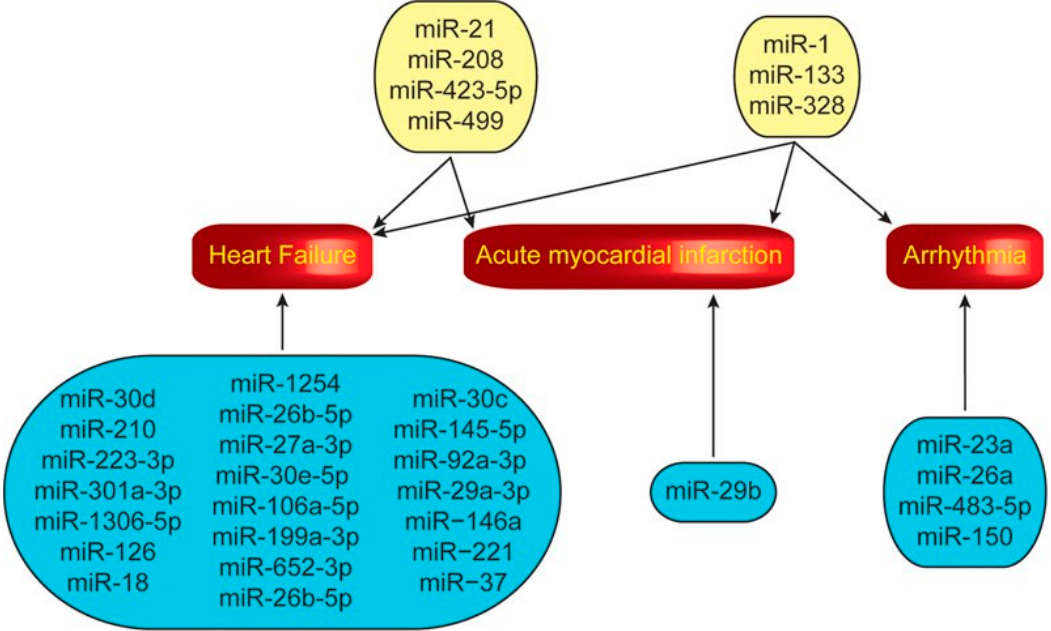
Figure 4. MicroRNAs (miRNAs) associated with heart failure, acute myocardial infarction, and arrhythmias. miRNAs in blue boxes correspond to those associated with only one of the three conditions while miRNAs in yellow boxes correspond to those associated with multiple conditions [110]. Copyright 2018 Springer Nature.